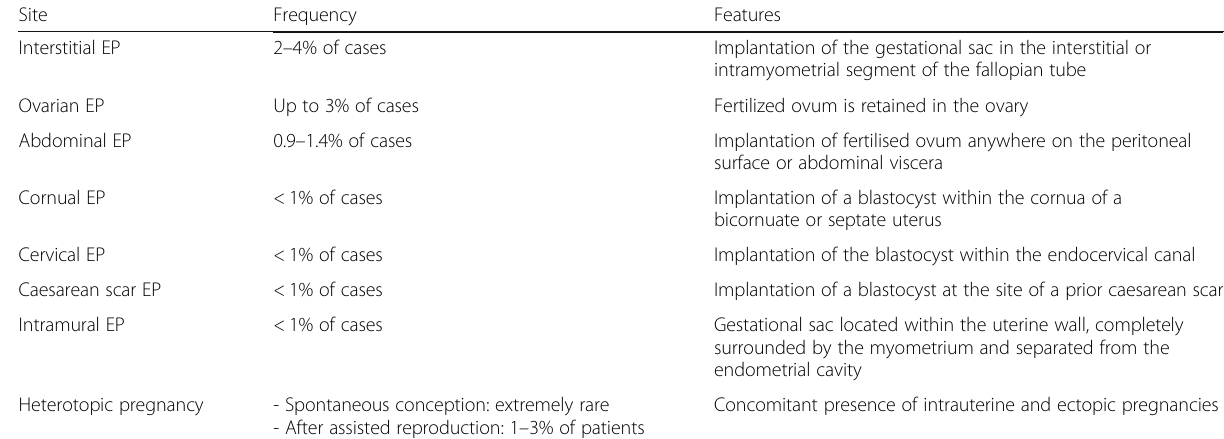
Table 4 Rare non-tubal implantation sites of ectopic pregnancy (EP)